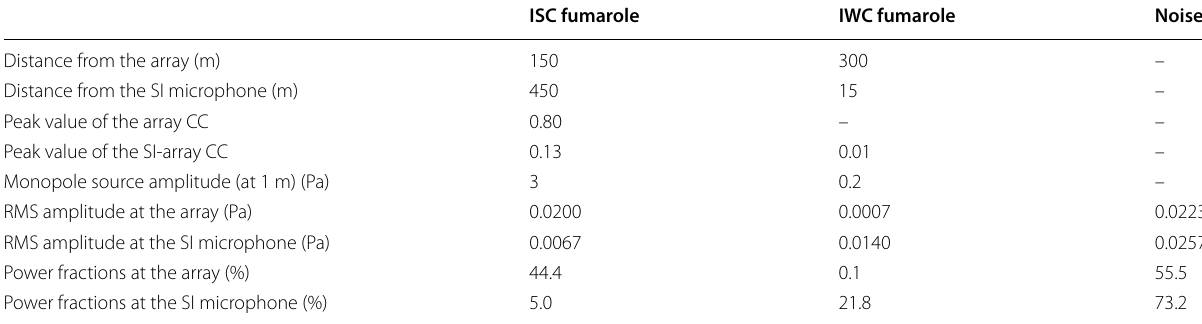
Table 1 Summary of the infrasound